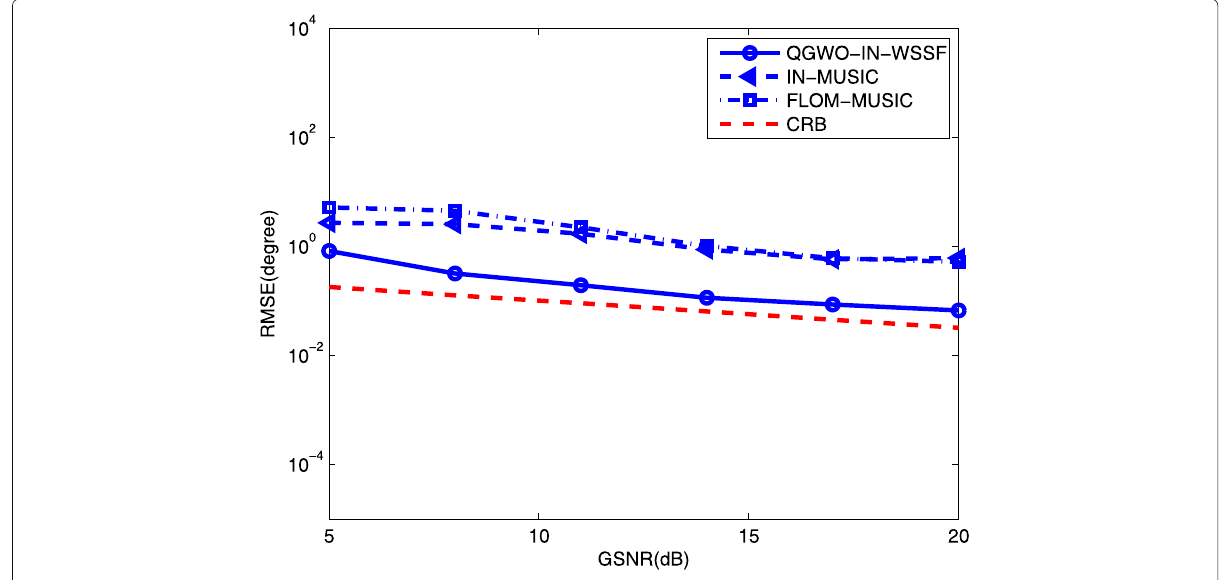
Fig. 8 RMSE curves and CRB versus GSNR for three independent sources with α =